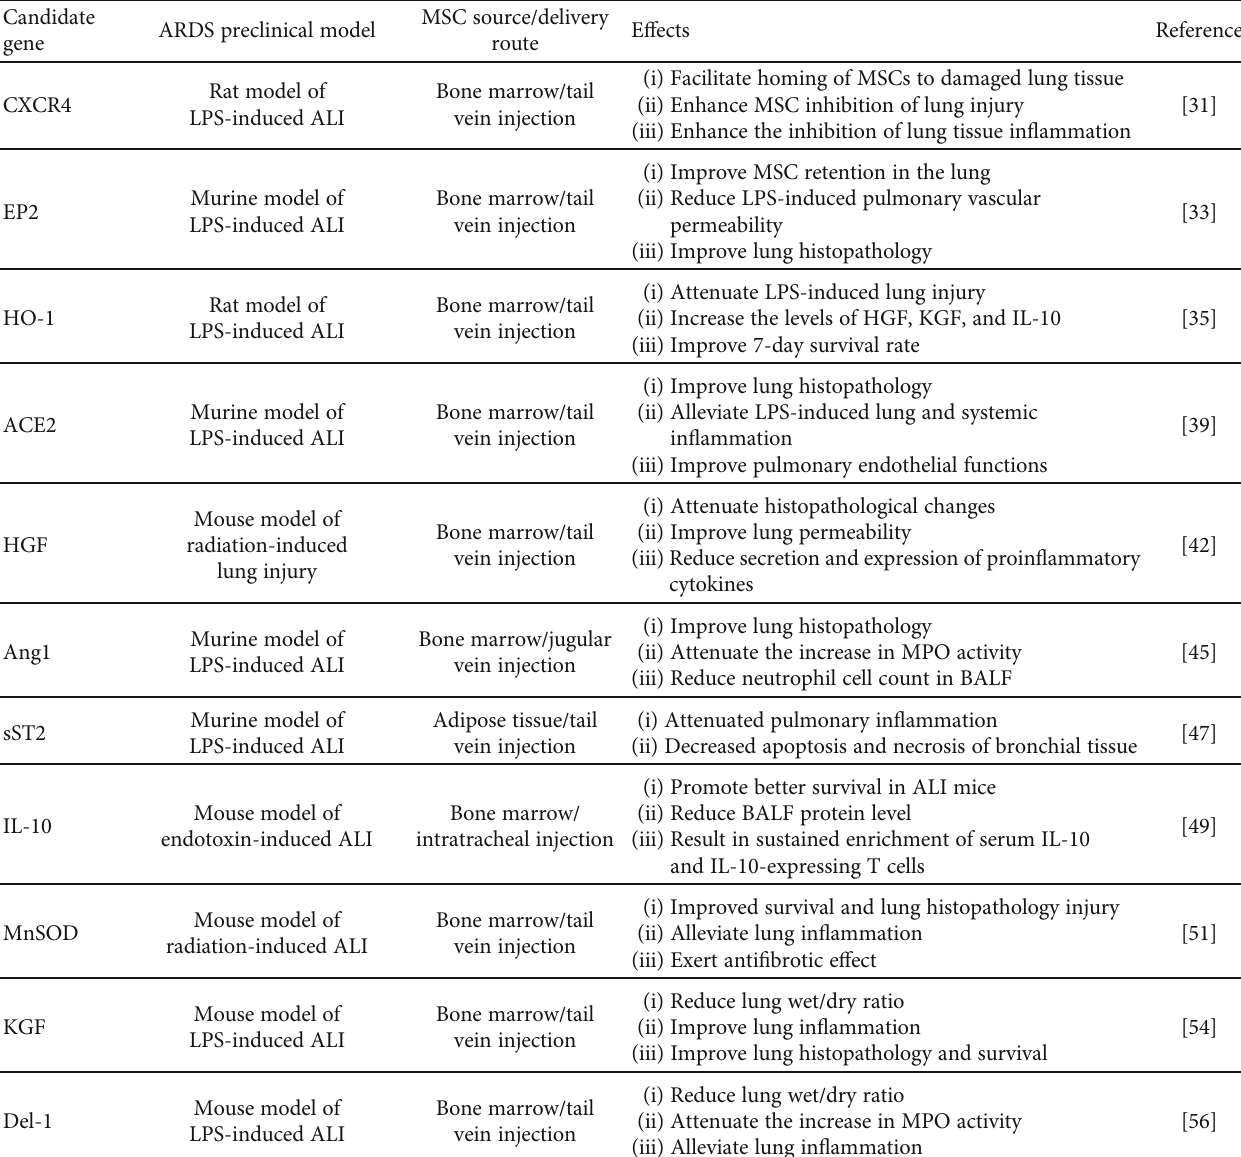
Table 2: Genetic modi fi cation to enhance MSC potency in ARDS preclinical